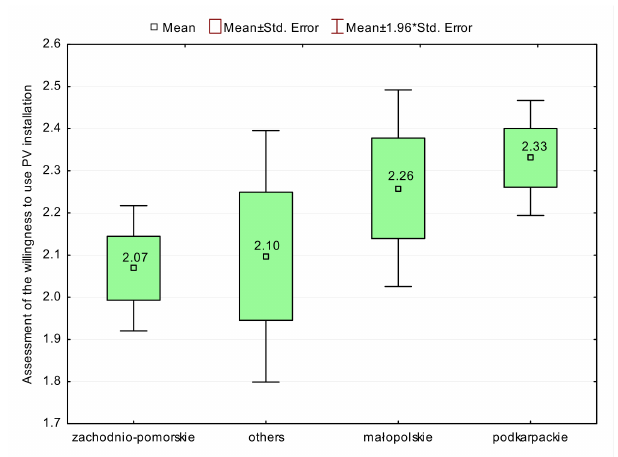
Figure 17. Region vs. assessment of the willingness to use PV